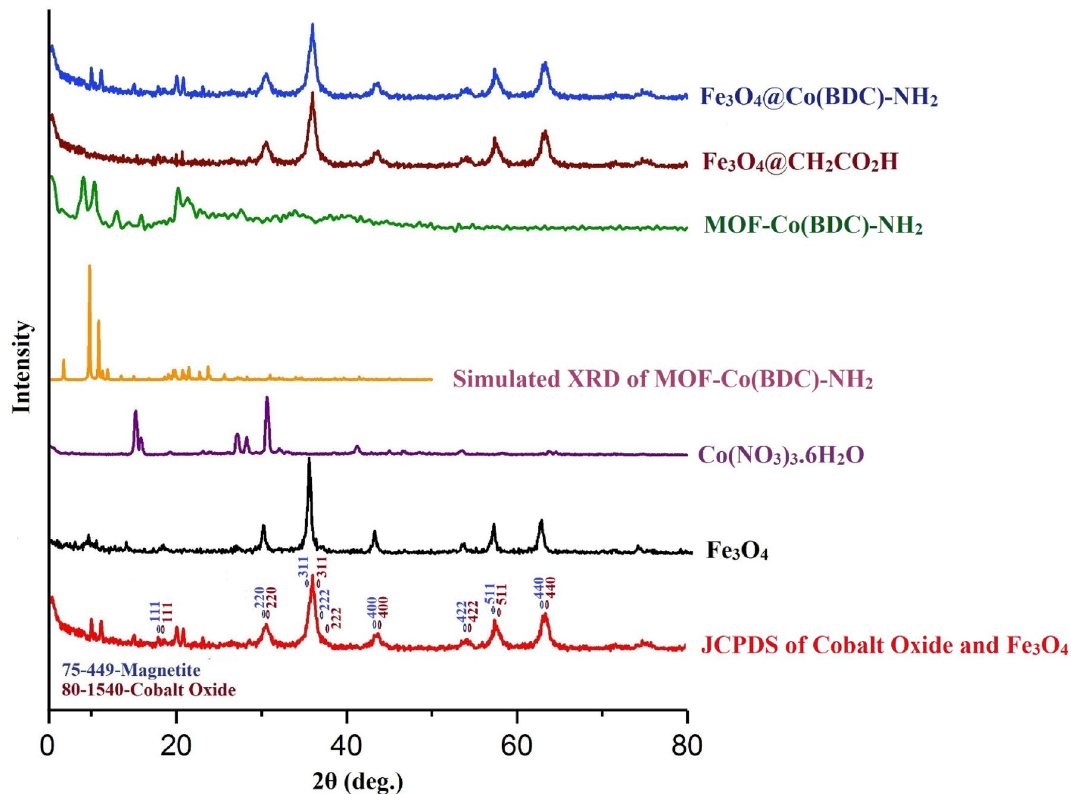
Figure 3. Comparison XRD pattern of JCPDS (red line), Fe 3 O 4 (black line), Co(NO 3 ) 3 ·6H 2 O (purple line), Simulated XRD (orange line), MOF-Co(BDC)-NH